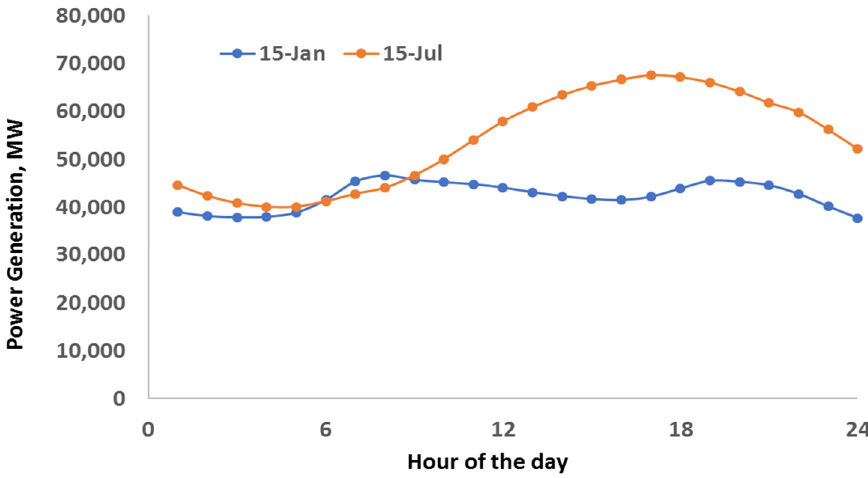
Figure 3. Hourly power generation in ERCOT during two days in 2019.